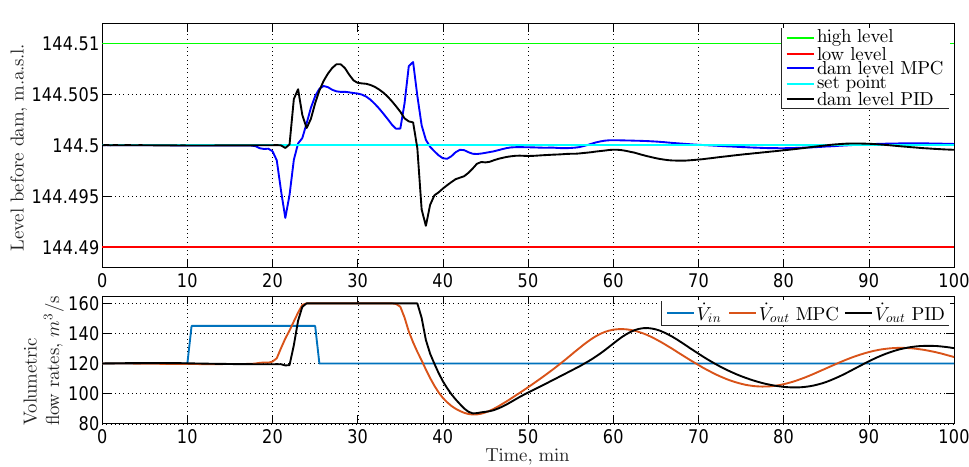
Figure 15: Comparison of MPC and PID controllers, where the outlet flow rate is a control signal. the power plant slightly better than PID, but of course, the simulation time for the MPC ( ≈ 1650 sec) is much longer than when using the simple PID controller ( ≈ 6 sec.); the PID controller can even show better results with shorter sampling time e.g. 5 sec (see Figure